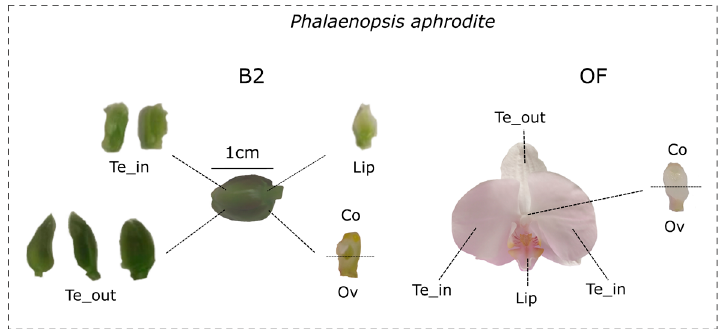
Figure 1. Flower and dissected organs of P. aphrodite at the B2 developmental stage (flower bud size 1–1.5 cm) and soon after anthesis (OF). Te_out, outer tepals; Te_in, lateral inner tepals; Co, column; Ov,